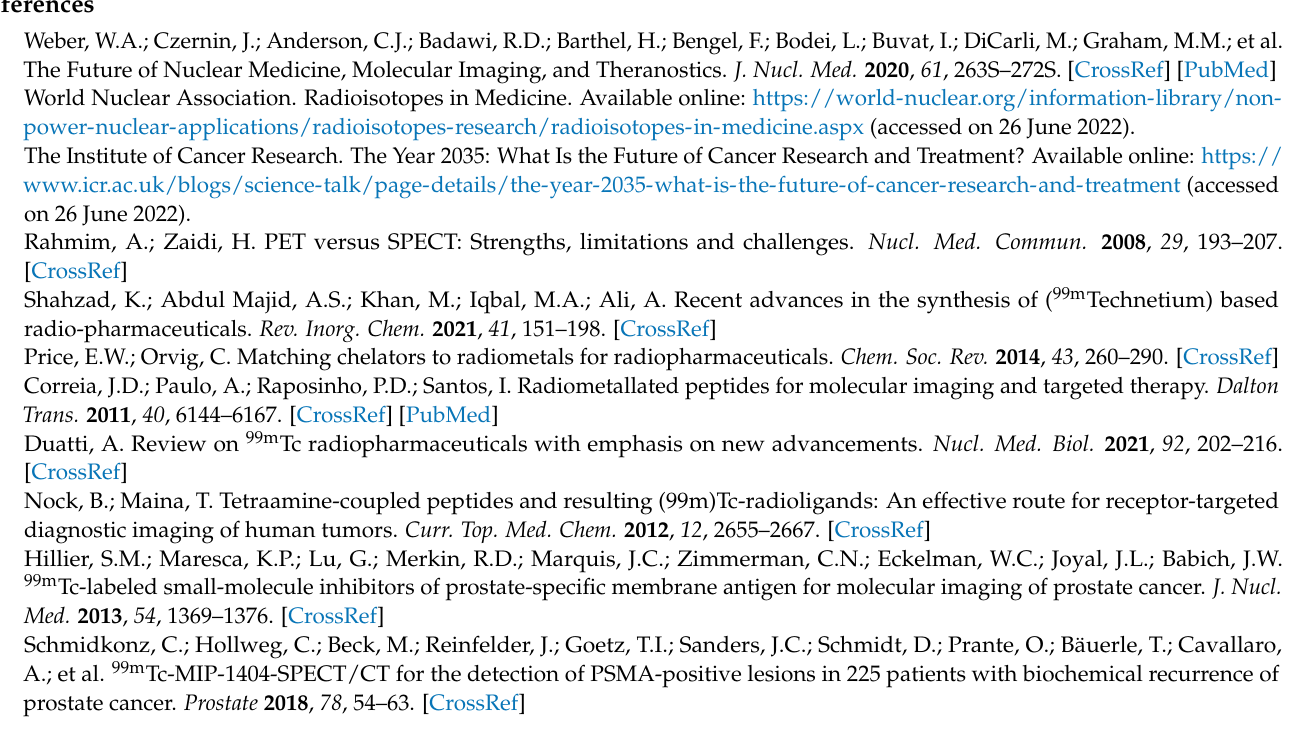
Table S2: Tumor/background ratios of 99m Tc-labeled MJ9 analogues for selected organs of PC-3 tumor-bearing CB17-SCID mice at 1 h p.i. ( n =